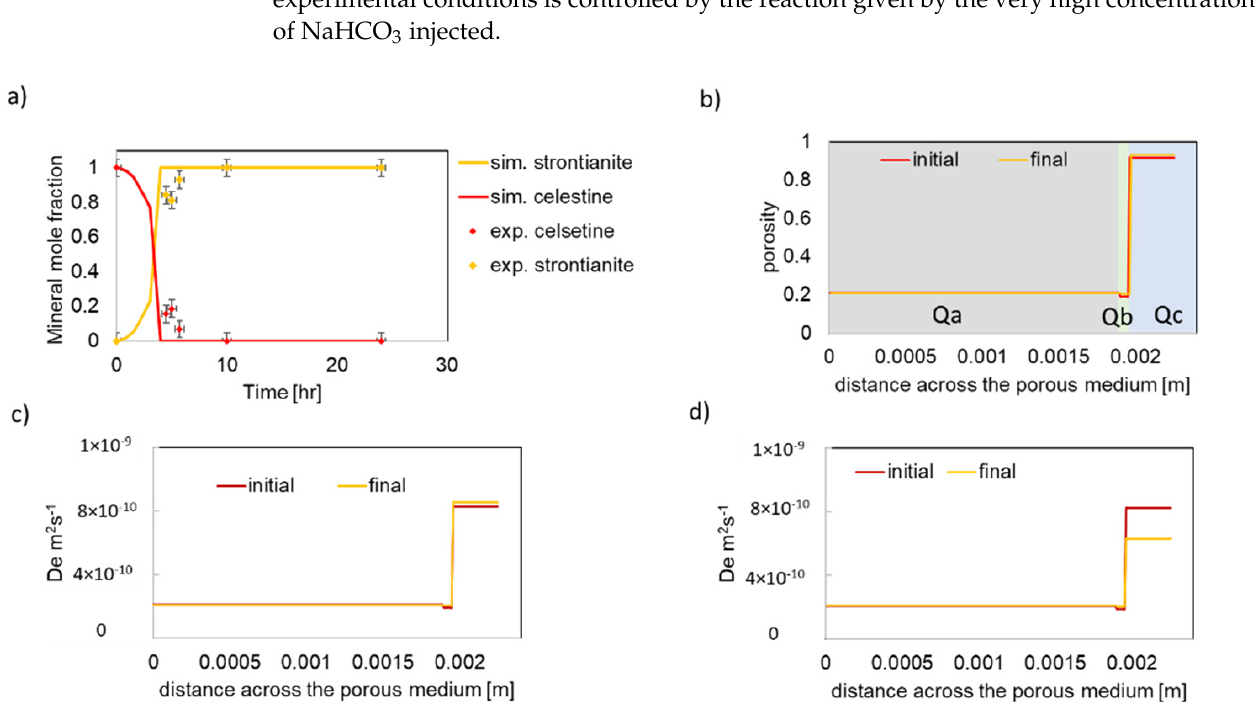
Figure 8. ( a ) Comparison between experimental and simulated temporal mineral reactions; ( b ) simulated initial and final net porosity across the porous medium ( c ) simulated diffusivity following Archie’s law, and ( d ) following the extended law (Equation (8)).